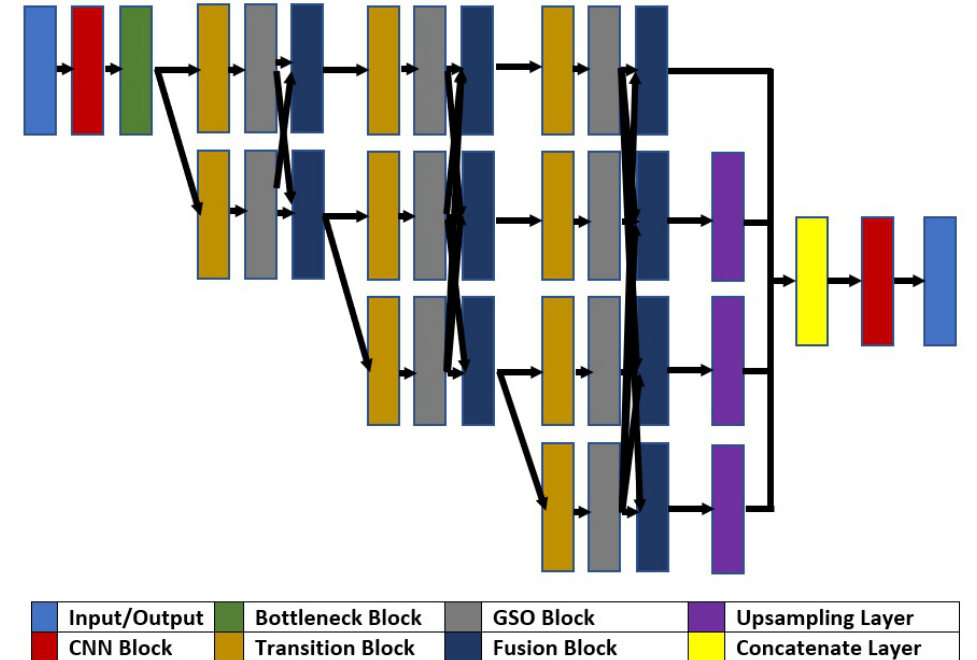
Figure 4. The full network architecture of the proposed GSHR-Net.